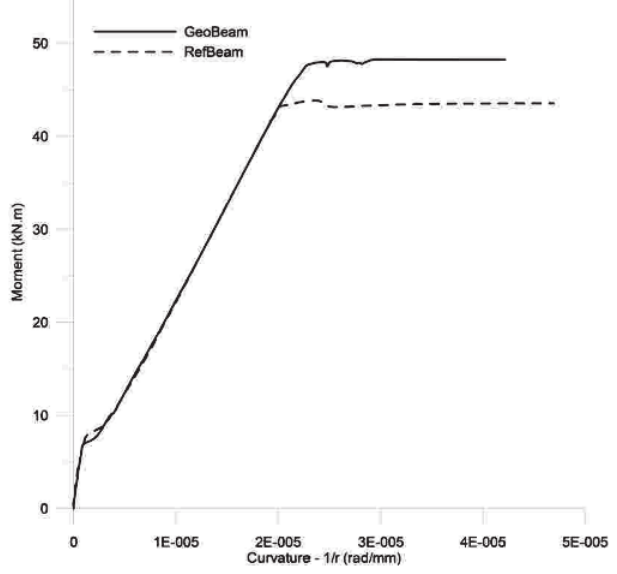
Figure 7 Moment vs curvature curves measured for the tested beams